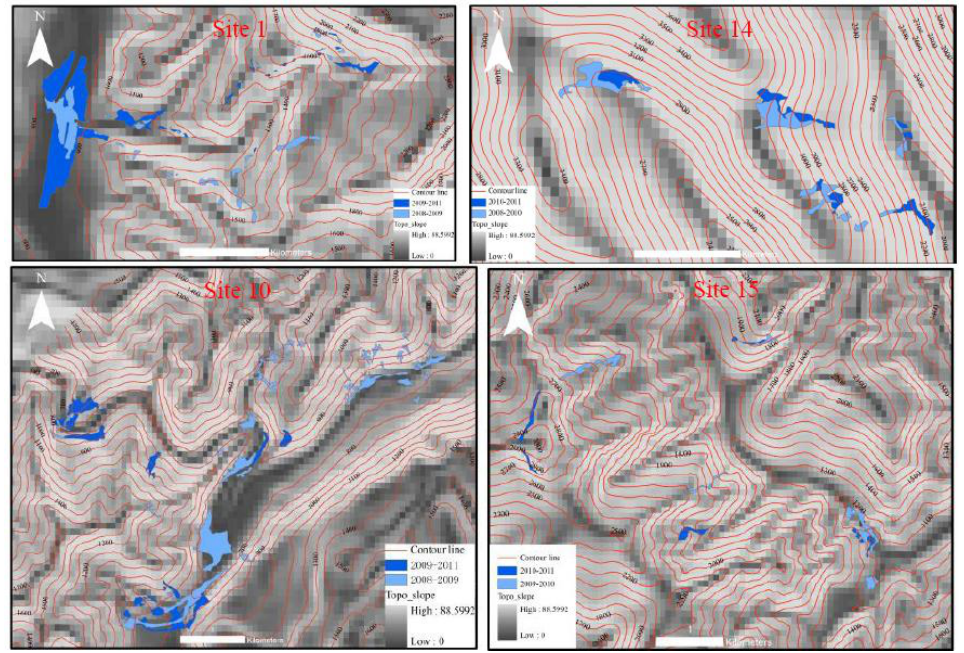
Figure 5. Changes in the debris flow regions of site 1, 10, 14, 15 from 2008 to 2009 and from 2009 to